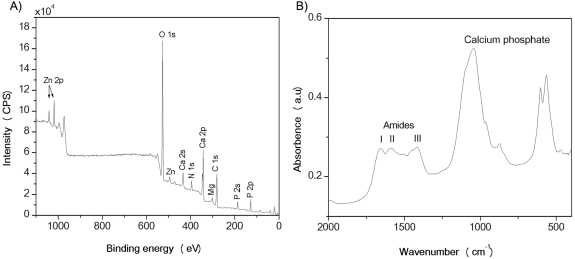
Chemical content of CA inclusions.(A) XPS survey and (B) FTIR spectra of powdered prostate CA material.